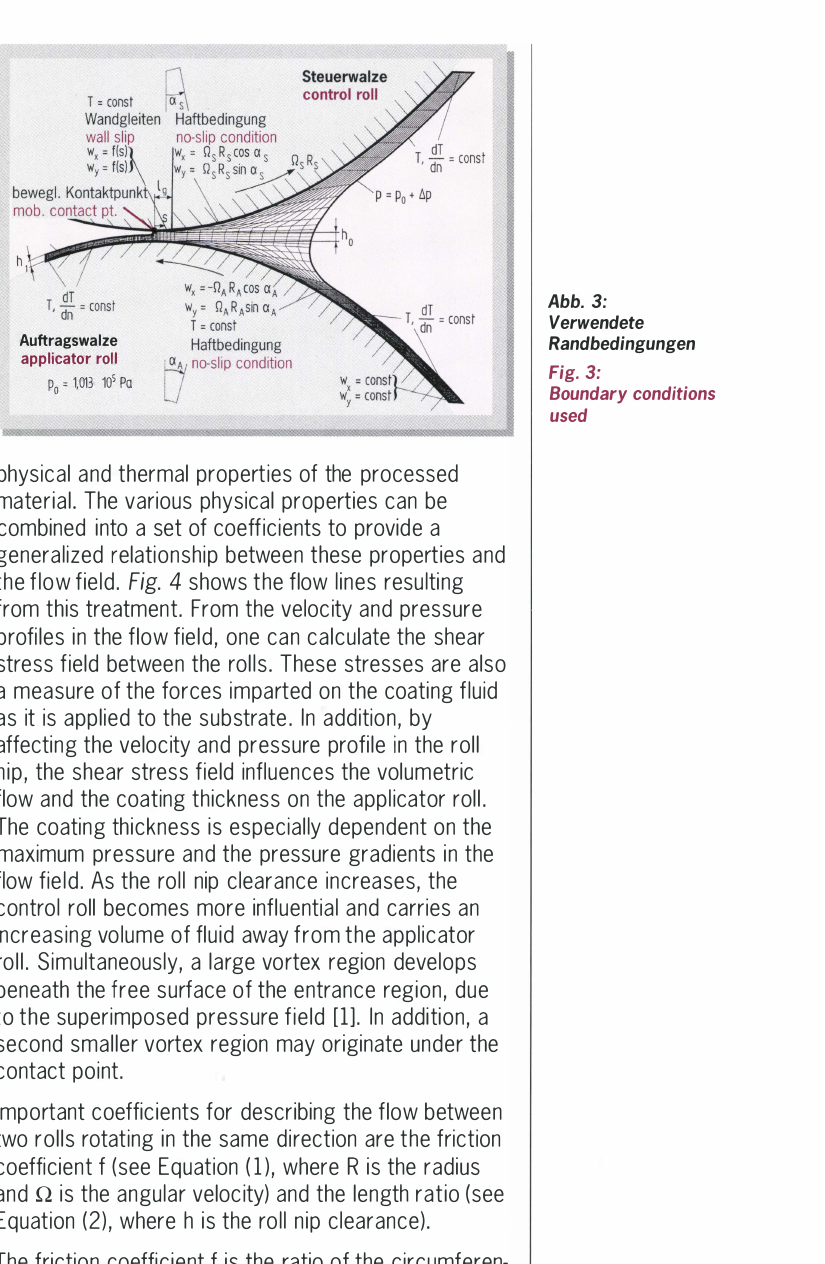
Fig. 2: Schematic design of a three roll coater